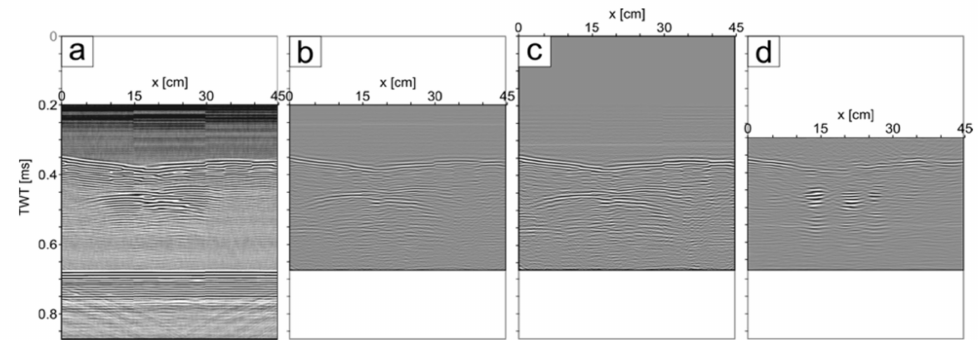
Figure 2. Seismic profile after different processing steps. ( a ) Raw data cut at TWT (two-way travel time) = 0.885 ms (first 0.2 ms not recorded). In x-direction, a tripartite segmentation due to recording with three transducers is noticeable by differences in water column noise and a small trace shift at x = 15 cm and x = 30 cm. ( b ) Cutting the traces at TWT= 0.68 ms removes the reflections of the box bottoms. Gain and bandpass filters are applied to the data, and deconvolution attenuates reverberation effects. ( c ) The initial 0.2 ms of the traces are padded with zeros, and trace normalization is applied. ( d ) Data following 3D migration. Reflections of three shells are visible, starting at TWT = 0.45 ms. Reflections at x = 13 cm and 21 cm are found at the shell’s center, while the reflection at x = 26 cm is on a shell’s edge. Later figures in this study only show data in the relevant range of TWT = 0.3–0.68